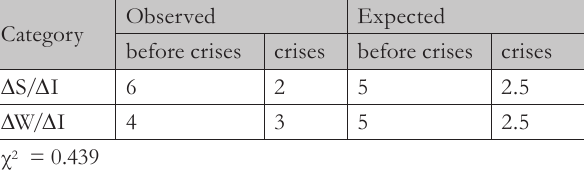
Tab. 4 – Pilot parameters of chi-square test hypothesis H2. Source: own research